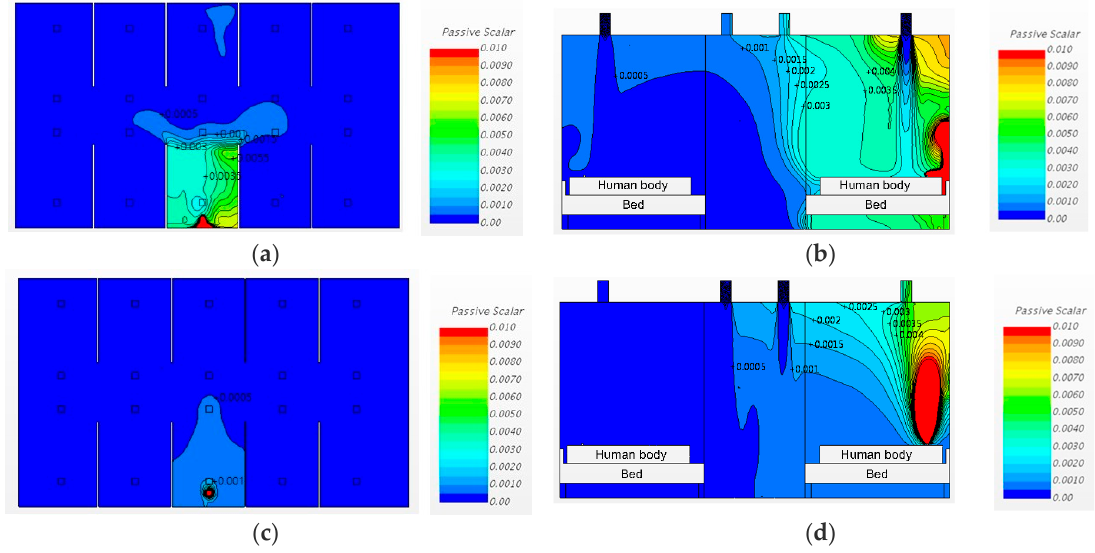
Figure 11. Airflow patterns and pathogen concentrations for Cases 7 and 8: ( a ) Case 7, plan view (h = 1.0 m); ( b ) Case 7, sectional view; ( c ) Case 8, plan view (h = 1.0 m); ( d ) Case 8, sectional view.